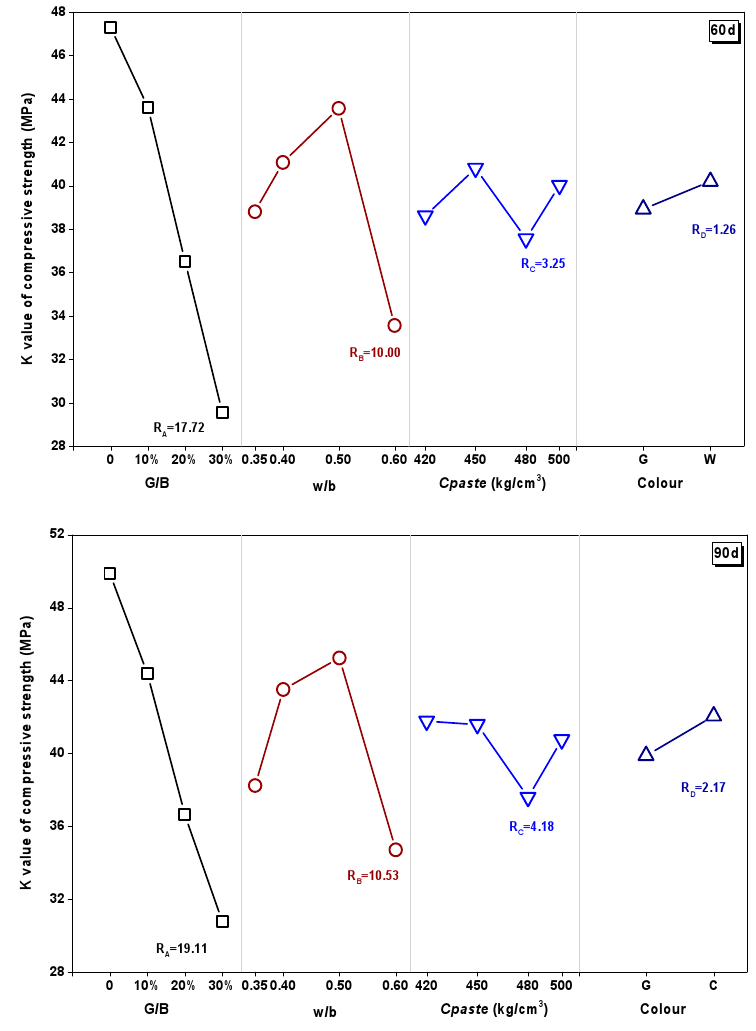
Figure 9. Factorial diagrams of the main parameters affecting the compressive strength of mixtures at 3 d, 28 d, and 90 d.